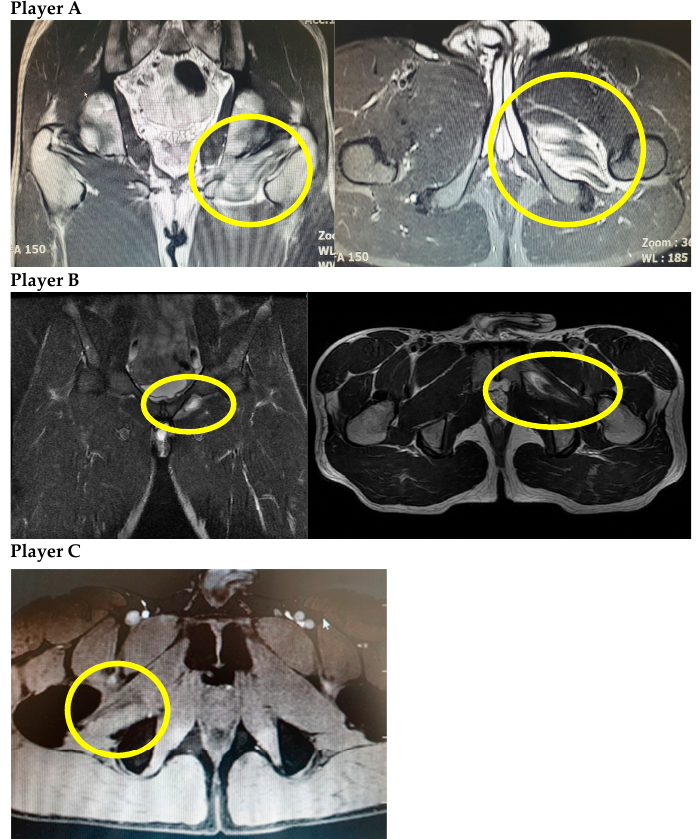
Figure 1. MRI of obturator externus injury in three professional soccer players. Player A : Hip joint MRI demonstrates grade II injury of left obturator externus muscle, coronal image (left) and axial image (right). Player B : Hip joint MRI demonstrates grade II injury of left obturator externus muscle, coronal image (left) and axial image (right). Player C : Hip joint MRI demonstrates grade I injury of right obturator externus muscle.